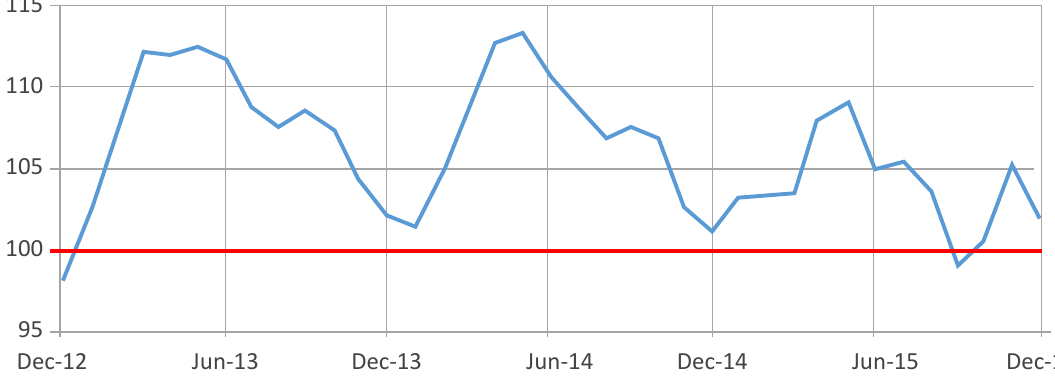
Figure 1. Real Sector Confidence Index